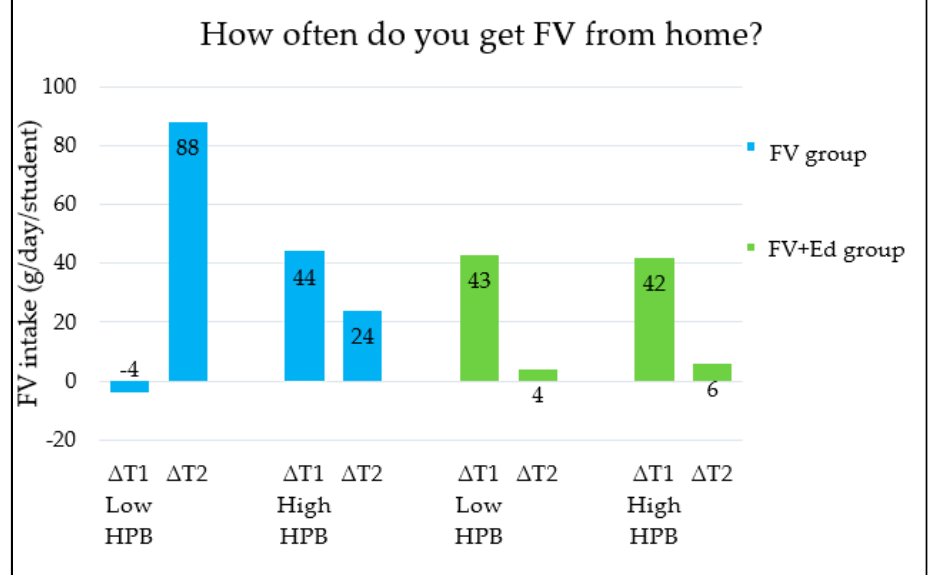
Figure 1. Differences in children’s FV intake, stratified by caregivers’ HPB in FV- and FV + Ed group, compared to control group—FV provision. HPB = caregivers’ health promotion behaviour, ∆ T1 = Difference between T0 and T1, ∆ T2 = Difference between T0 and T2.